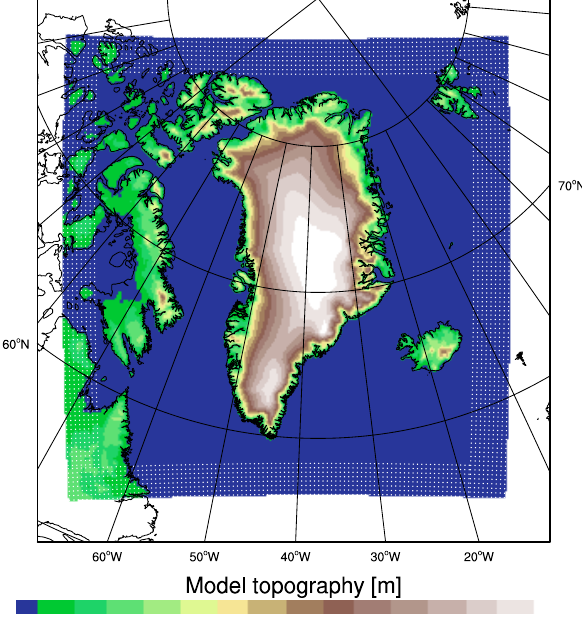
Fig. 1. Overview of model domain. Model topography is shown in Fig.1. Overviewofmodeldomain. Modeltopographyisshownin colors,bluerepresentsocean.Thewhitedottedboundaryrepresents colors; blue represents ocean. The white dotted boundary represents themodelrelaxationzone(24gridpoints). the model relaxation zone (24 grid